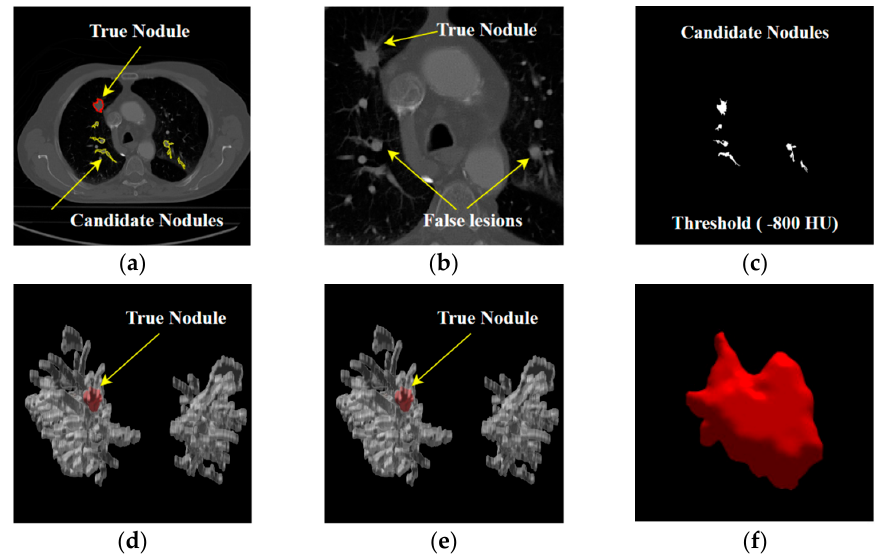
Figure 9. Segmentation of the nodule candidates: ( a ) input 2D CT slice, ( b ) zoomed-in view of the parenchymal internal structures, ( c ) 2D nodule candidate segment, ( d ) isotropic structure of the segmented nodule candidates, ( e ) isotropic structure of blob enhancement lesions, ( f ) isotropic structure of the true tumor nodule.